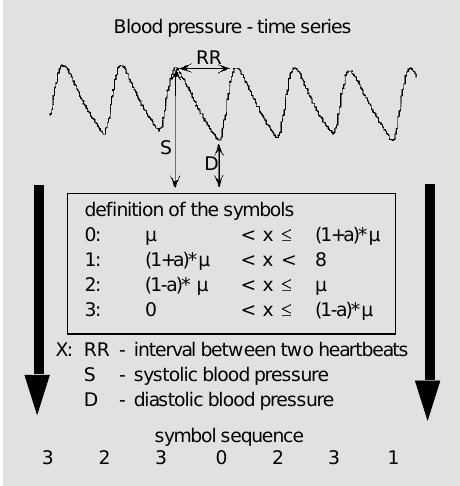
Figure 1 - The basic principle of symbolic dynamics, i.e., the transformation into symbols.